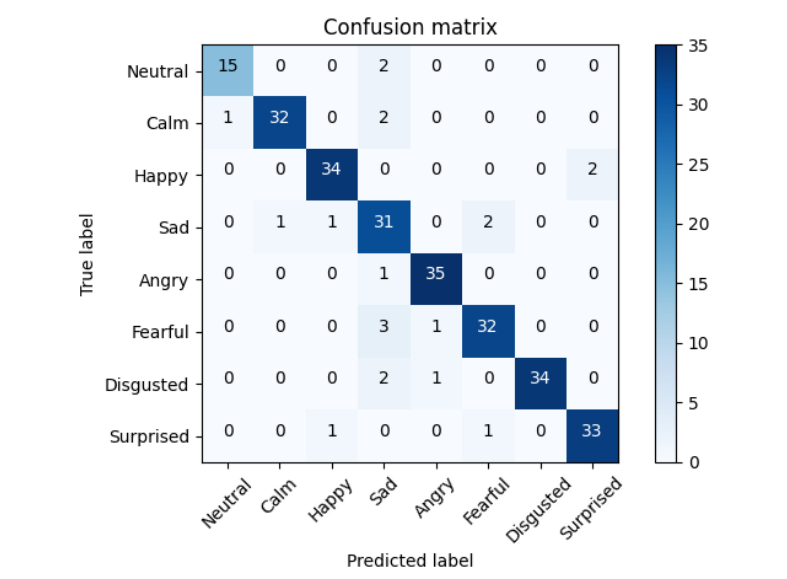
Figure 8. Average confusion matrix of the top late fusion model that combines the posteriors of the FT-xlsr-Wav2Vec2.0, the bi-LSTM, and the MLP of 80 neurons. Accuracy of 86.70%. See Figure